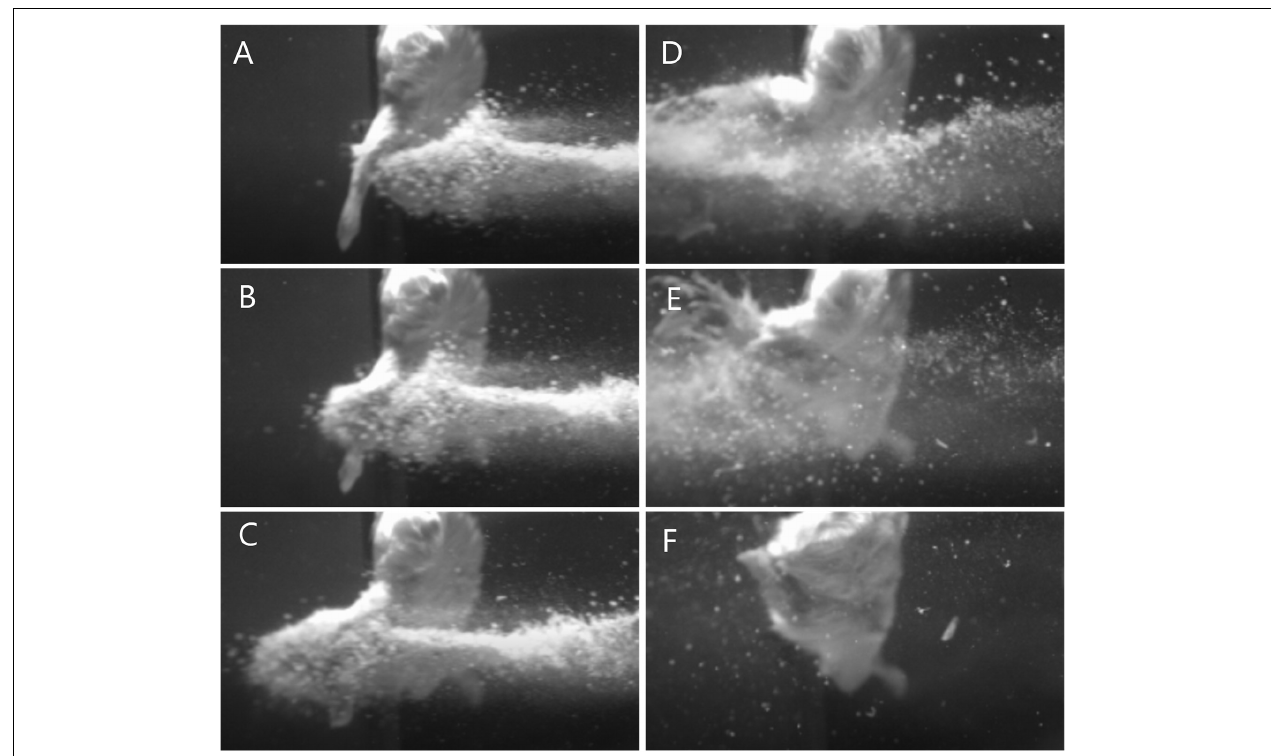
FIGURE 4 | Images illustrating the stages of traumatic amputation secondary to high velocity sand blast. (A) Immediately pre-impact. (B) Point of initial impact. The sandy gravel has begun to move through and around the tissues of the lower limb at high velocity. Due to the experimental setup the foot has evaded the trajectory of the sandy gravel, whilst the limb above has begun to fragment and displace relative to the foot below. (C) The foot has been pulled upward into the trajectory of the sandy gravel, whilst the skeletal and soft tissue above are now significantly fragmented and displaced. (D) The lower limb has now been entirely shattered and displaced, with soft tissue stripping on the periphery of the blast now evident as the muscle is seen moving outwards. (E) As the sand blast dissipates, the remaining surrounding soft tissues can be seen more clearly to be stripped and displaced. (F) Completed traumatic amputation. (A schematic to provide context of the animal’s position and orientation is provided in Figures 2A,B